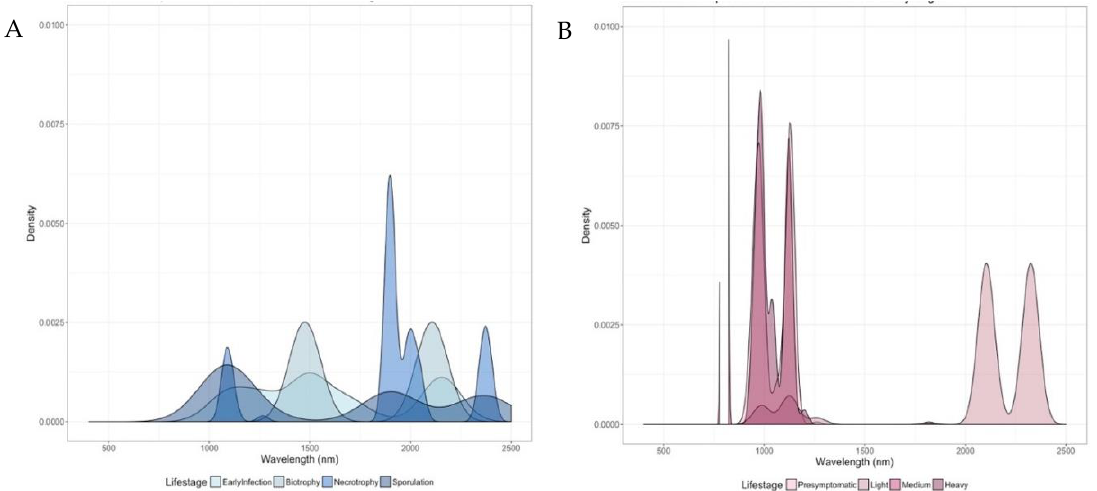
Figure 4. Density plots of distribution of the wavelengths used in the top 300 most correlated NDSIs for all potato late blight life stage models ( A ) and potato early blight disease stage models ( B ). Height of peaks indicate a higher concentration of correlated wavelengths in that spectral region.